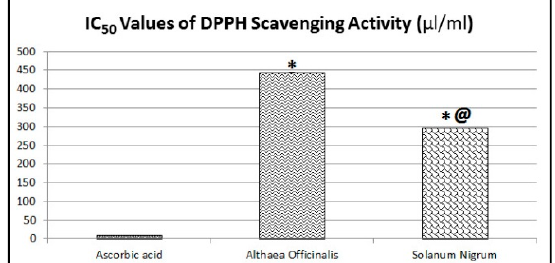
Figure 2. In vitro anti-oxidant activity of aqueous extracts of Althaea officinalis flower and ethanolic extracts of Solanum nigrum fruit. Each value signifies the mean ± standard error of the mean.